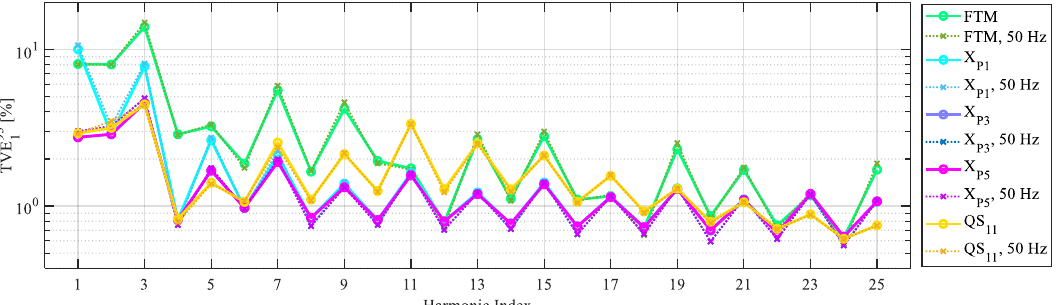
Figure 6. TVE 1 95th percentile bands for the different behavioral models, random fundamental frequency.